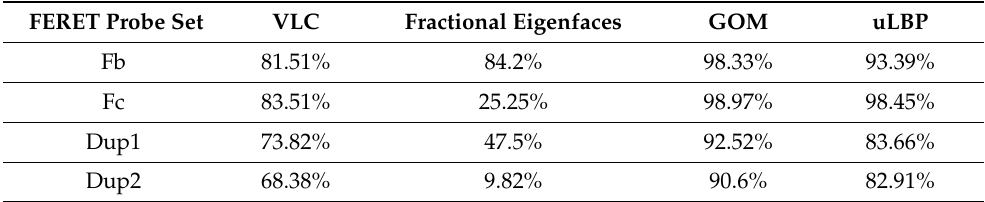
Table 5. Comparison between the recognition rate results obtained by Ghorbel et al. [49] with the VLC and other three methods for face recognition, with four different probe sets from the FERET database.